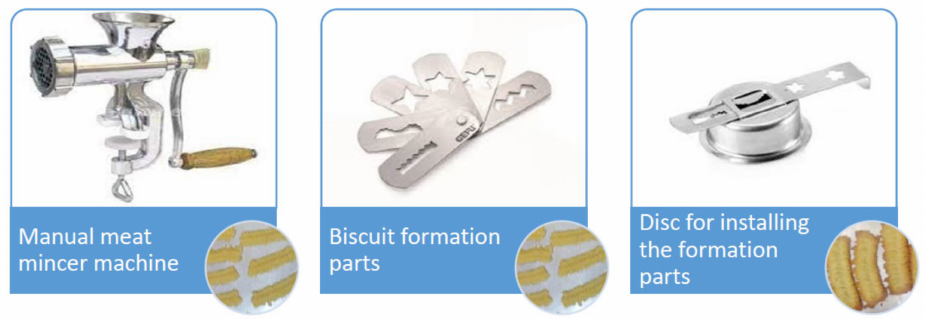
Figure 2. Manual meat mincer machine, modified for biscuit